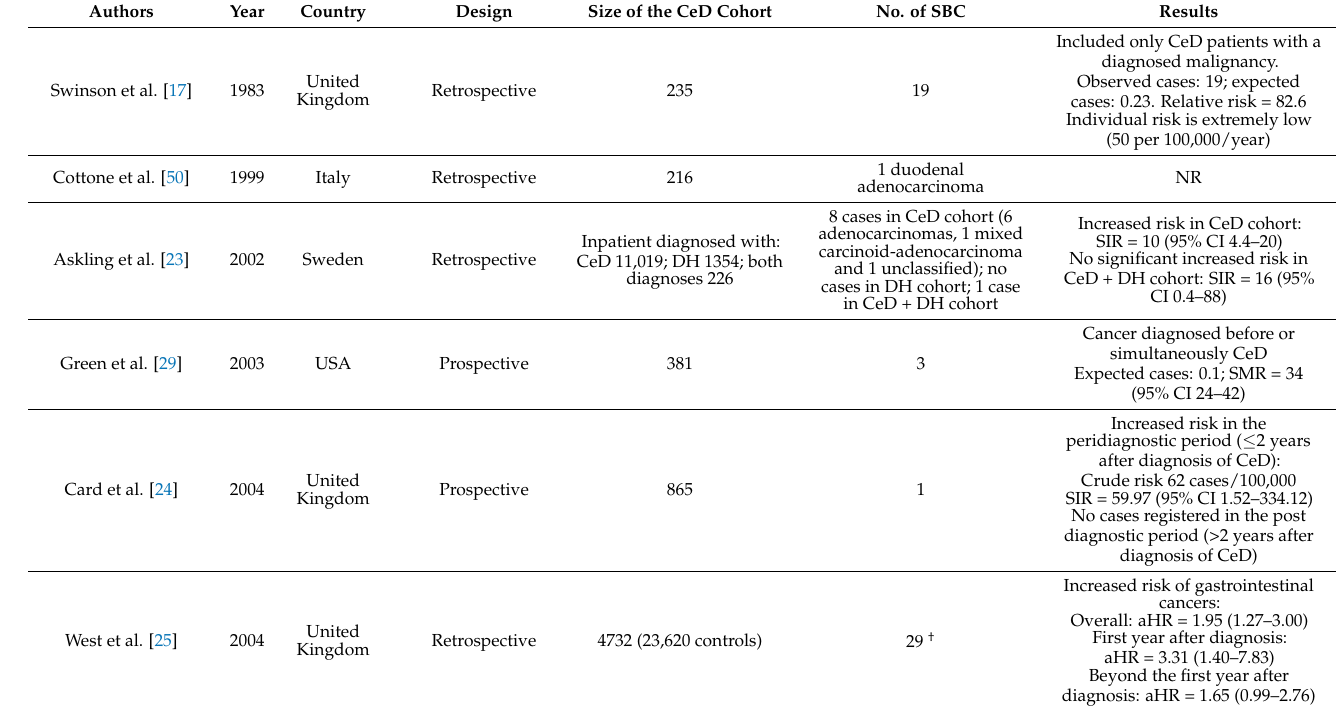
Table 3. Studies evaluating the risk of small bowel carcinoma (SBC) in patients with